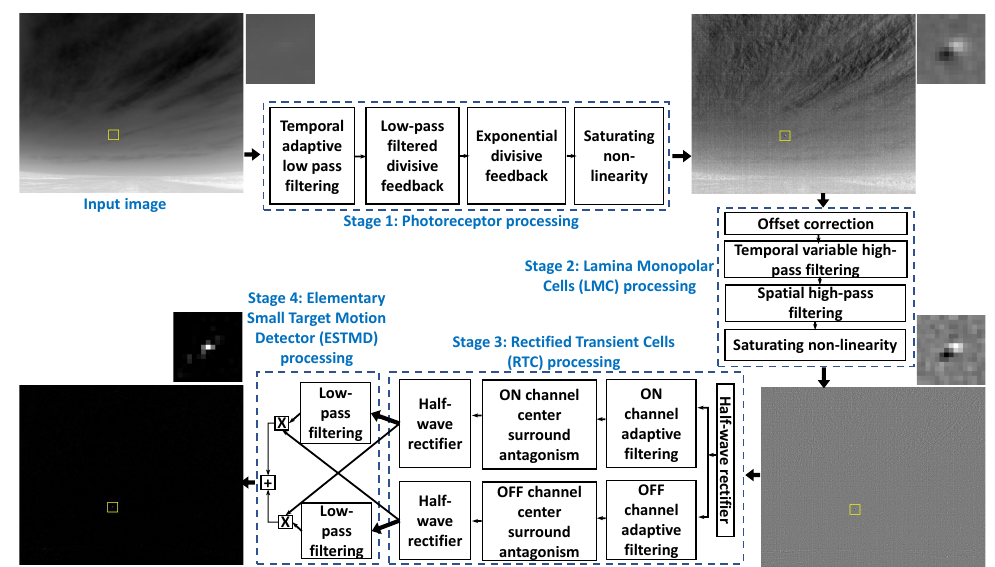
Figure 2. Processing mechanisms and spatial input/output of different stages of the bio-inspired vision based (BIV) target detector. The small size and minimal thermal signature target (X8 drone) is at 520 meters from the camera in this example. The first two stages of the model pre-process the frame to significantly increase the target contrast both spatially and temporally with respect to the background. Stage 2 (LMC) is specifically effective in suppressing the clutter produced by the slow moving clouds and static ground structures. The ESTMD stage outputs a detection map where high values corresponds to detected target